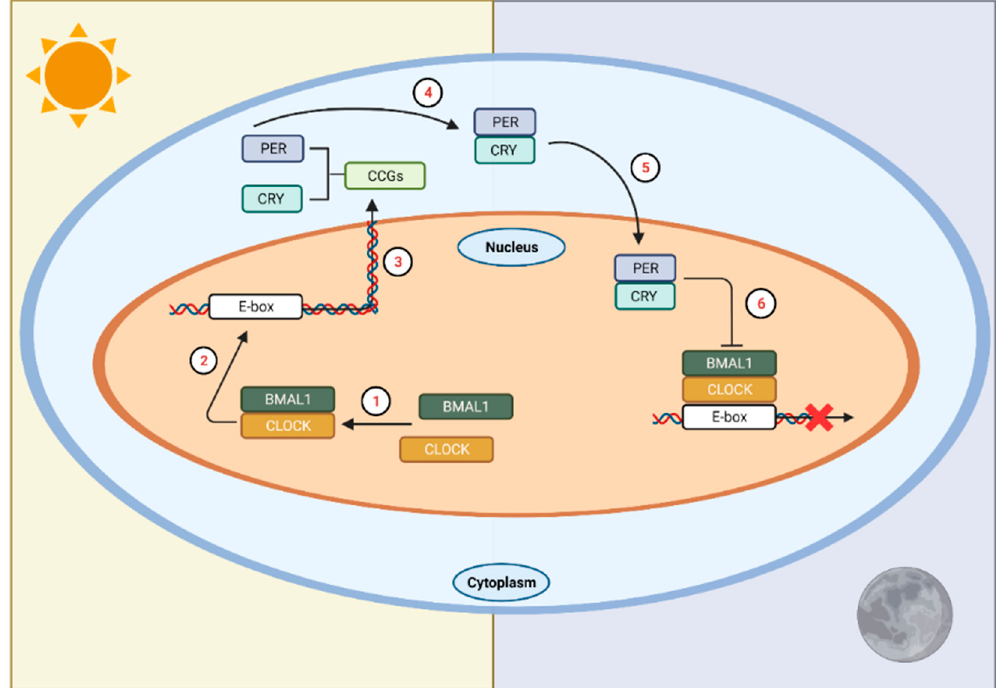
Figure 1. The circadian clock in mammals. In SCN neurons at the start of the circadian day, BMAL1 and CLOCK form a heterodimer (1) that binds to E-box sequences in the promoters of the Cry and Per genes (2) to activate their transcription (3). This marks the beginning of the circadian day. The gene products of Per and Cry accumulate in the cytoplasm, dimerize (4), and then form a complex that translocates into the nucleus (5) to interact with CLOCK and BMAL1, ultimately repressing their own transcription (6). This process takes approximately 24 h. LAN affects the timing of this transcription/translation cycle leading to temporal misalignments affecting physiology and behavior. CCGs = circadian clock genes. Figure was created using Biorender.com (accessed on 13 January 2022). In order to maintain the strength of this biological rhythm, this TTFL is tightly regu- lated at multiple levels. Specifically, regulation has been documented at the